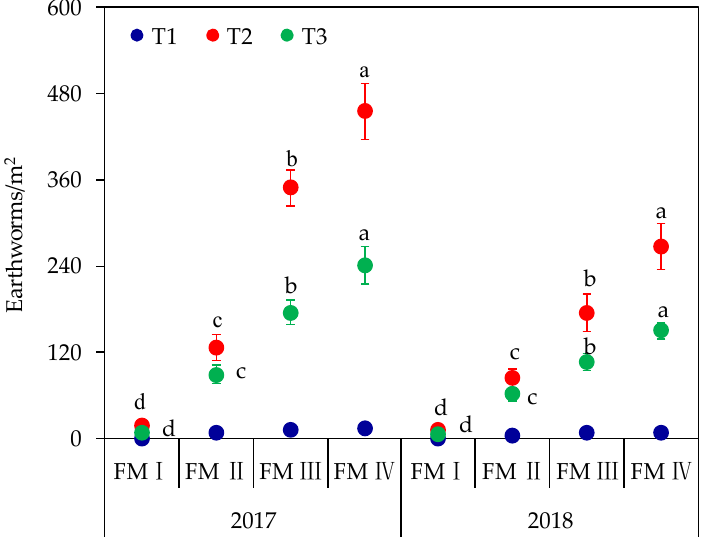
Figure 4. Effect of field margins (FM) size on earthworm abundance in FM in response to flooding. T1, T2, T3 represented the sampling time of earthworms before flooding, 1 day after field flooding, 60 days after field flooding, respectively. Data were medians with 95% confidence intervals ( n = 3). Treatments having no letters in common represented significantly differences (S-N-K, p < 0.05).